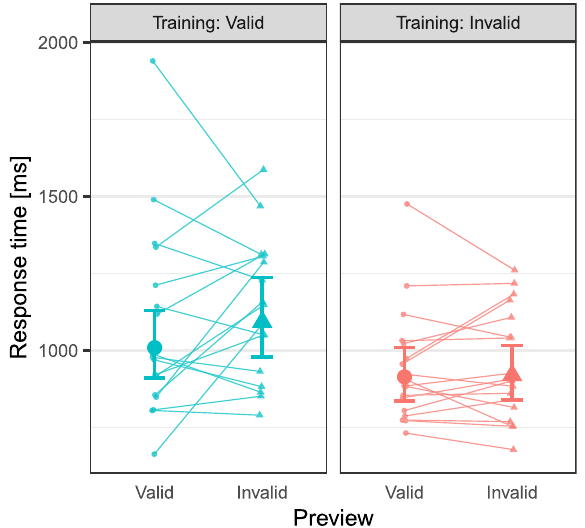
Figure 2. Estimated marginal means from the maximum identified model on response time data (Model 2). Individual participants’ conditional modes are illustrated with smaller symbols and thin lines connecting the valid and invalid preview points. The preview effect, the difference between valid and invalid preview trials, depended on the training condition. In contrast to valid training (left side), there was no evidence for a preview effect with invalid training (right side, see also Models 2a and 2b below). Note that effect estimates were obtained for the first trial of the test phase. Error bars represent 95% asymptotic confidence